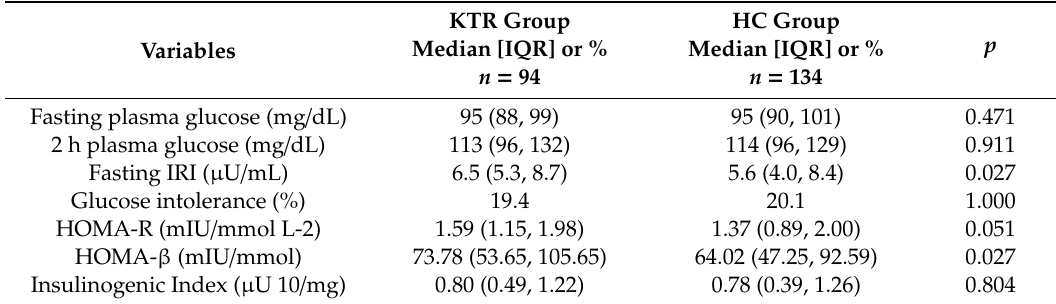
Table 2. Glucose intolerance between kidney transplant recipients and healthy controls.